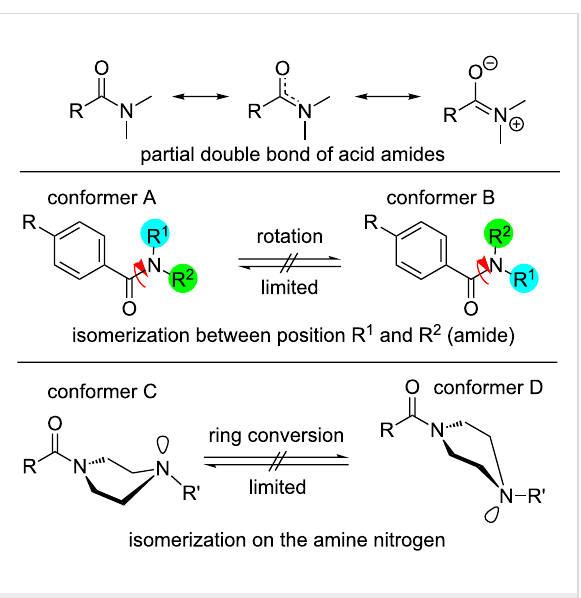
Figure 3: Illustration of the general partial double bond character of an amide bond and the limited isomerization of the amine nitrogen atom which results in possible conformers of piperazine compounds.